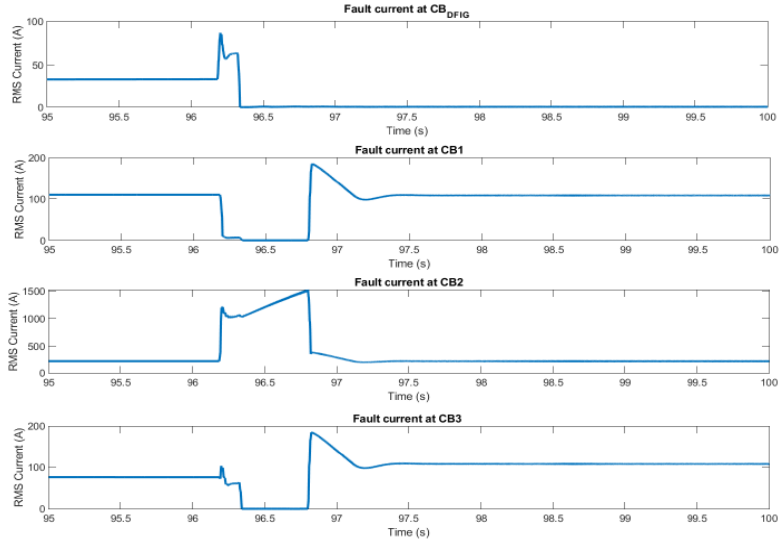
Figure 16. Sympathetic tripping of CB DFIG for fault 2 at CB2 location in a conventional protection system.